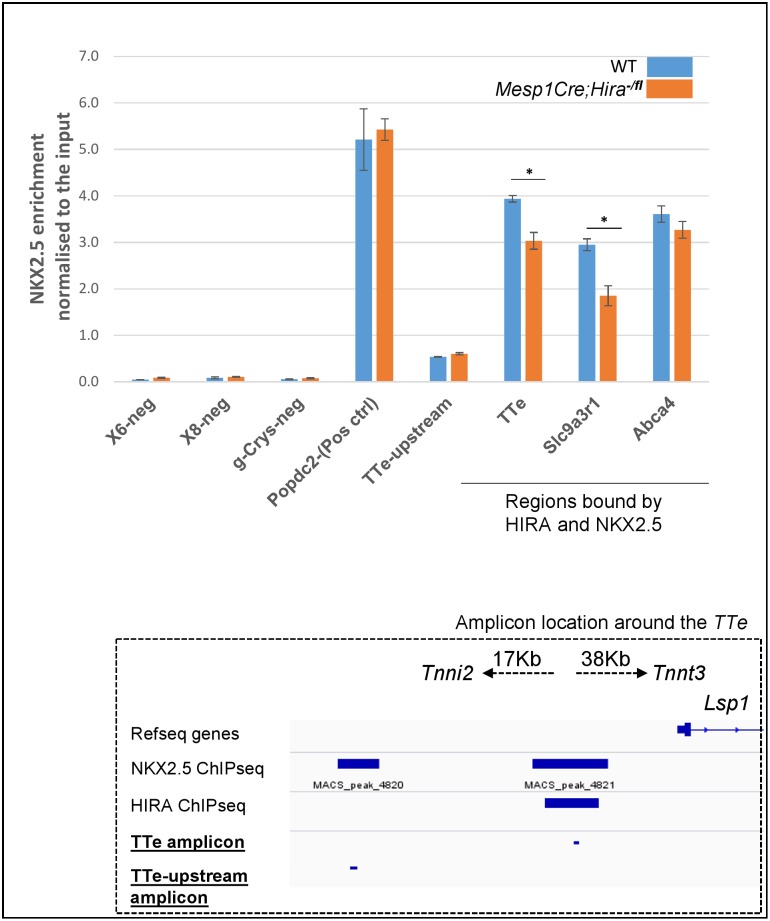
NKX2.5 shows diminished binding at the TTe locus in conditionally HIRA depleted hearts.NKX2.5 qChIP on 20 WT and Mesp1Cre;Hira-/fl E12.5 hearts. Enrichment at the TTe was confirmed and found to be reduced in mutant hearts. Slc9a3r1 and Abca4 were enriched for both HIRA and NKX2.5 in WT hearts and displayed an increased expression in both Hira and Nkx2.5 mutant hearts. SLc9a3r1, but not Abca4, showed a significantly reduced binding of NKX2.5 in the absence of HIRA. Three different negative regions were tested. A region known to be enriched for NKX2.5, but not HIRA, binding (Popdc2) was used as a NKX2.5 qChIp positive control. Data is normalized to the input (= 100). Errors bars represent the min/max from technical duplicates. Unpaired t-test: p<0.05 *. Subpanel represents the different ChIPseq peaks along with the PCR amplicons used in the different qChIp at TTe, and at a locus bound by NKX2.5, but not by HIRA.